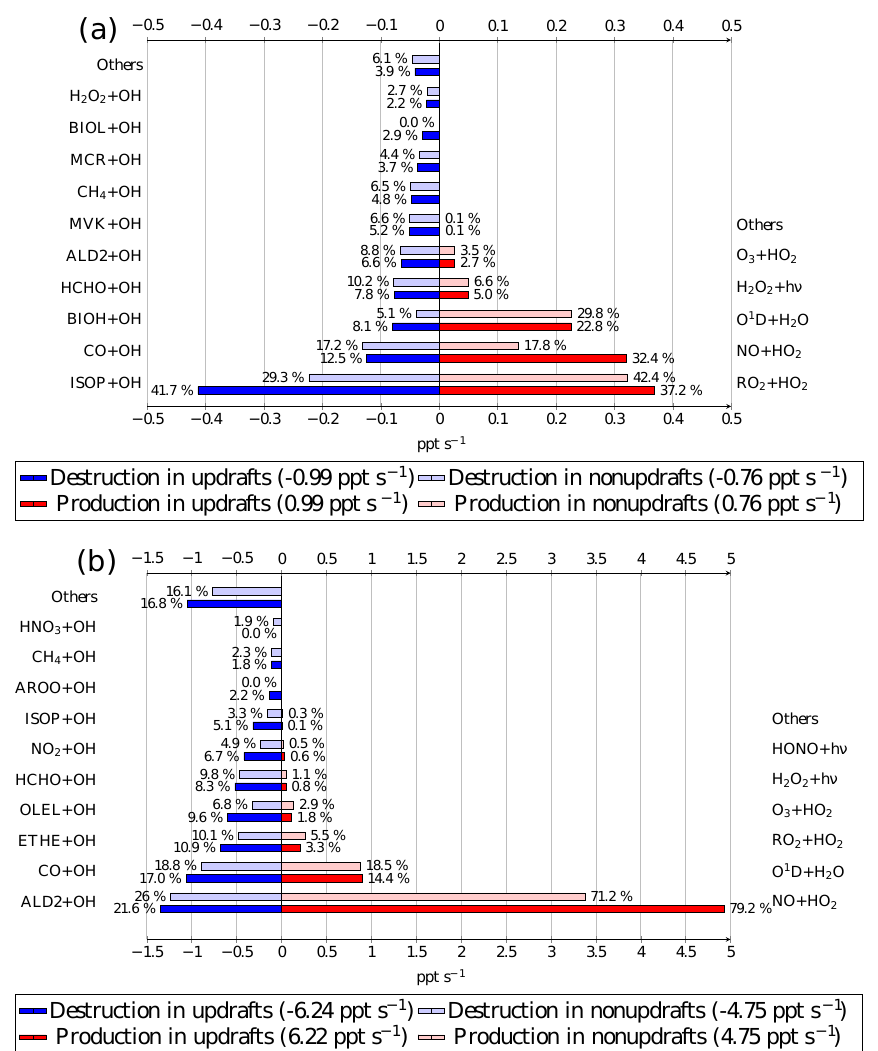
Figure 7. OH radical chemical budget at 12:00UTC averaged at 20m for the biogenic (a) and the anthropogenic case (b) . Source terms are in red for updrafts and pale red for nonupdrafts. Destruction terms are in blue for updrafts and pale blue for nonupdrafts. The bar lengths determine the absolute values, and the relative contributions for destruction and production are given by the percentage near each bar. Numbers between parentheses in the legend box are the OH production and destruction rates in updrafts and in nonupdrafts. Chemical names correspond to the names given in the ReLACS 3